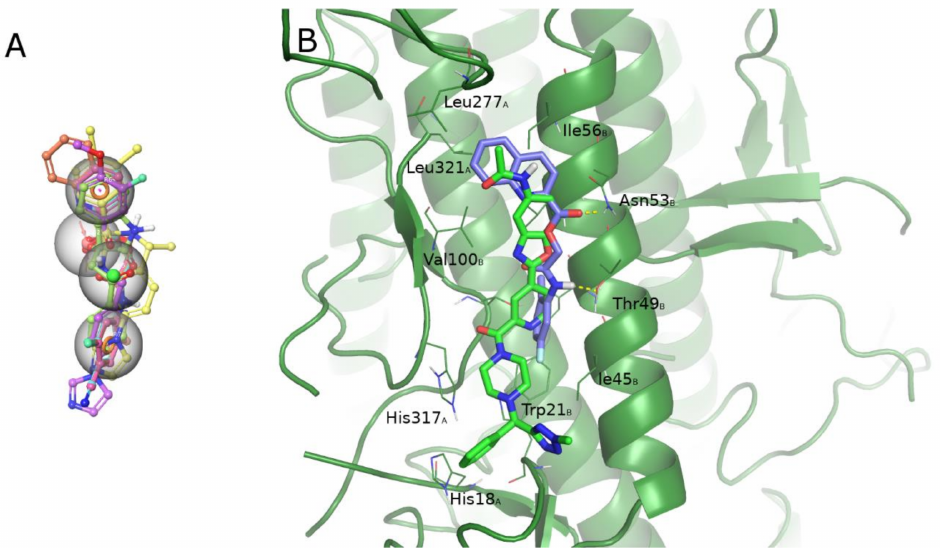
Figure 5. ( A ) The pharmacophore hypothesis obtained aligning the two X-ray ligands binding the stem region of HA, and characterized by two aromatic rings (orange rings), one H-bond acceptor (red sphere), and one hydrophobic (green sphere) feature. All six active ligands are aligned to the hypothesis matching all the features. ( B ) Docked pose of ligand 4 (violet C atoms) in the binding site on the stem region superimposed to the X-ray ligand (PDB ID 6CF7). HA (A/Parma/H1N1) is represented as a green cartoon. Residues involved in the ligand-binding are represented as lines; residue name is followed by a subscript indicating the HA